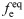
Relative bias of the intracellular lifetime as a function of ΔR2tE.The ratio of τi,r/τi as a function of ΔR2tE, is shown for six different sets of fe0 and feeq values. The solid blue lines are calculated from Eq 25, while the dashed red lines are calculated from Eq 24. The framed plot shows the bias from low fe0 and 50% extracellular fraction, which approximately corresponds to our experimental conditions. The vertical dotted line is at ΔR2tE = 0.6, which corresponds to echo time tE = 17 ms and the difference in relaxation rate constants ΔR2 = 35 s−1. Here the relative bias (solid blue line) is about −20%.